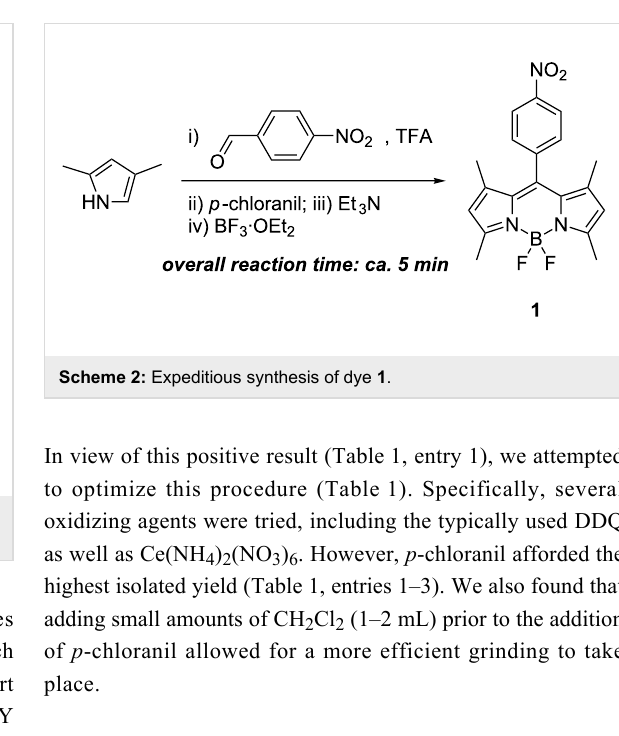
Table 1: Optimization of reaction conditions for the synthesis of dye 1